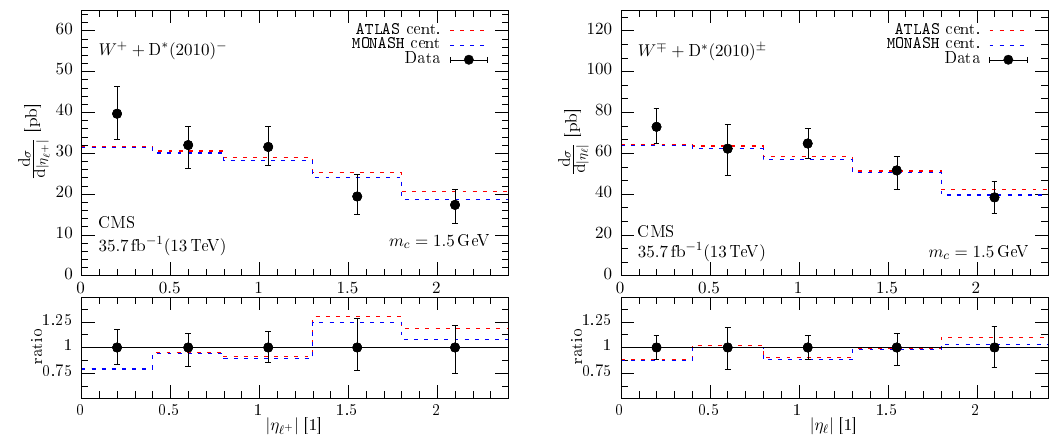
Figure 5 . Same as in figure 3 and 4, but limited to central predictions with two different PYTHIA8 tunes (Monash and ATLAS A14 central tune with NNPDF2.3LO PDFs). The two panels refer to the µ + case (left) and to the µ + + µ − case (right),